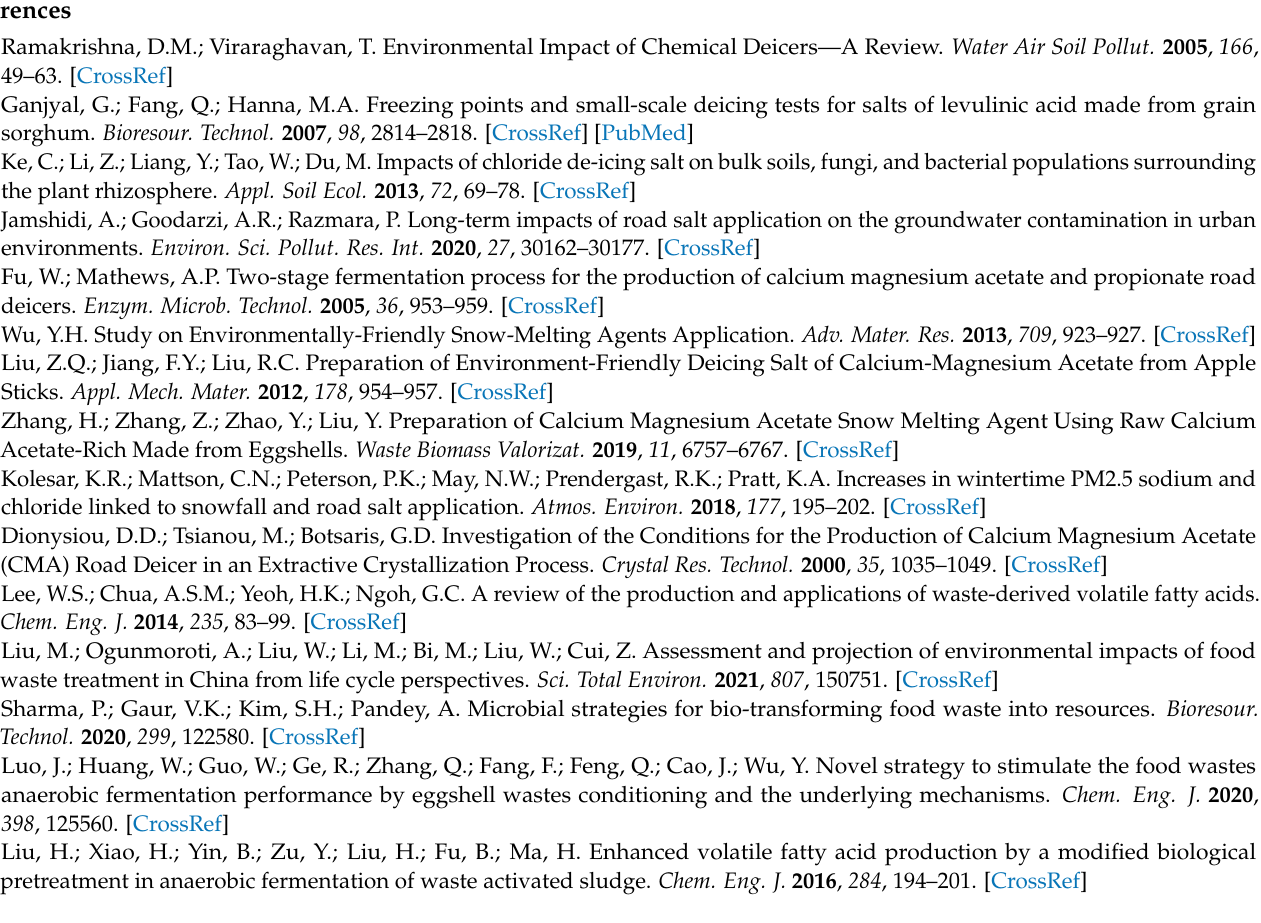
flux, Figure S2: Infrared spectrogram of product, Figure S3: XRD spectrogram of product, Figure S4: SEM images of product. Table S1: The one-way analysis of variance for protease activity under stage I and II, Table S2: The one-way analysis of variance for α -GLC activity under stage I and II, Table S3: The one-way analysis of variance for ACK activity under stage I and II, Table S4: Ingredients in organic deicing